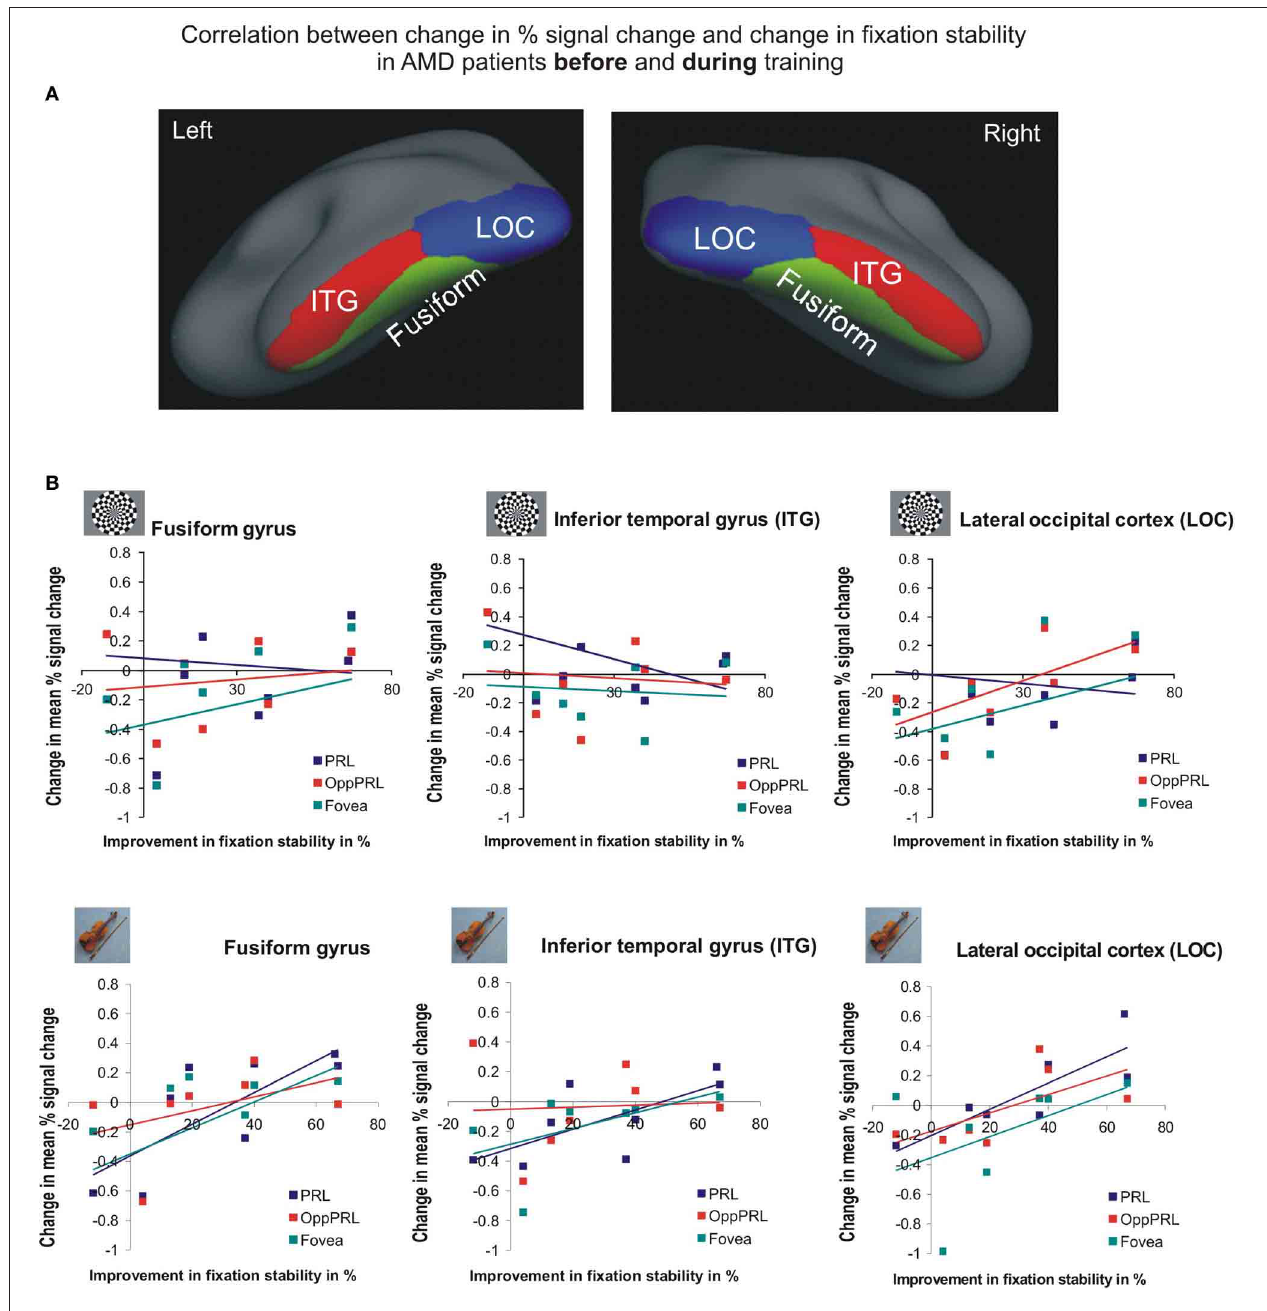
FIGURE 10 | Correlation between the change in% signal change and change in fixation stability for the patient group only before fixation training and during fixation training in the inferior temporal gyrus (ITG), the lateral occipital cortex (LOC), and the fusiform gyrus [(A) as labeled in Freesurfer]. (B) The upper row depicts the correlation between